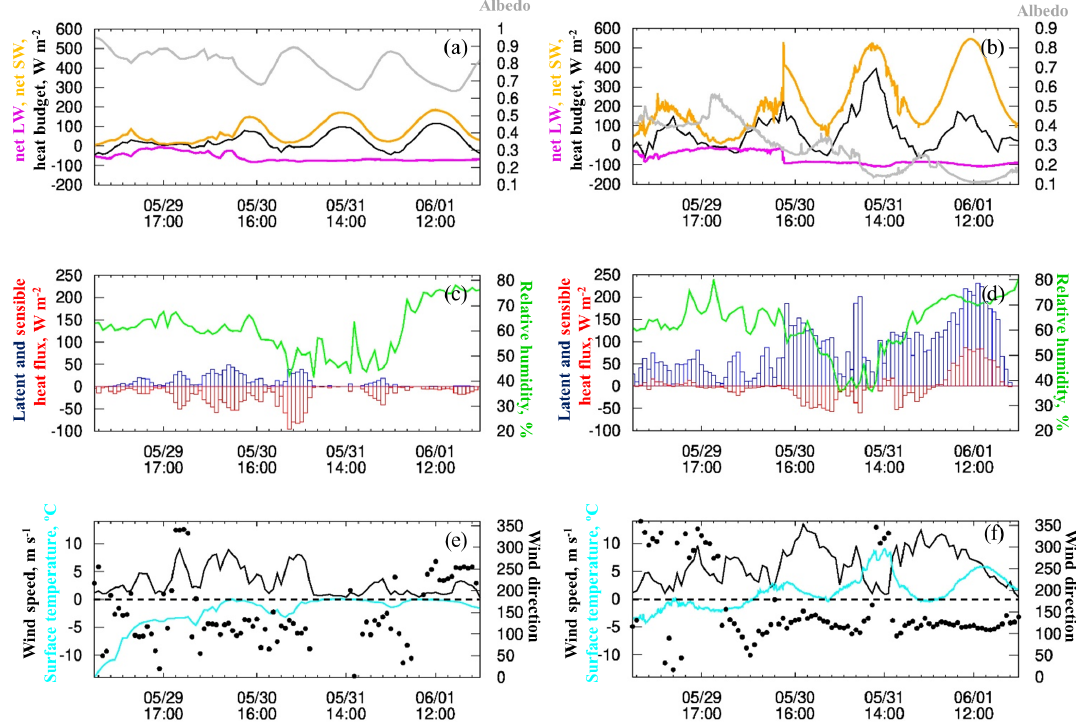
Figure 11. Terms of the radiation and heat budget in Ny-Ålesund (a, c, e) and Adventdalen (b, d, f) during 29 May–1 June 2017: (a, b) net shortwave (orange line) and net longwave (magenta line) radiation and residual term of heat budget (black line) and albedo (gray line), (c, d) turbulent heat fluxes (sensible (red boxes) and latent (blue boxes)) and relative humidity (green line) at 2ma.g.l. (c) and 10ma.g.l. (d) , and (e, f) wind speed (black line) and direction (points) at 10ma.g.l. and surface temperature (cyan